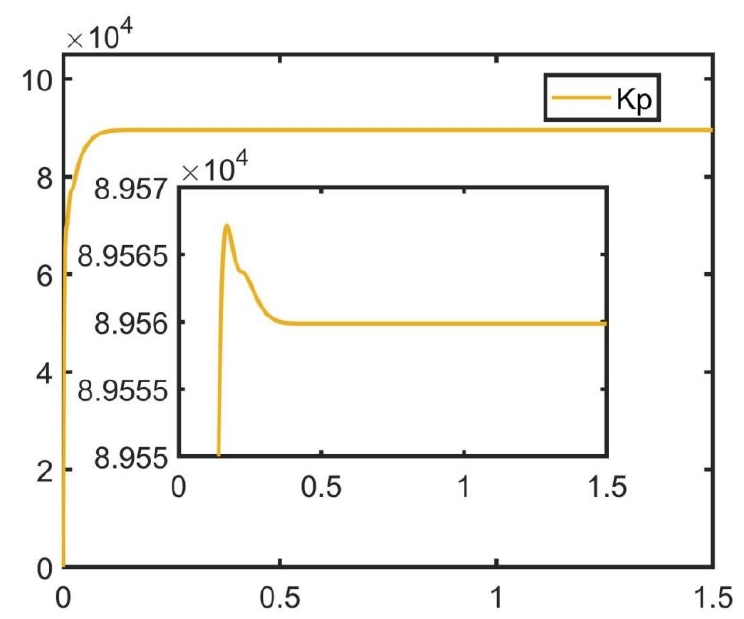
Figure 5. Adaptive adjustment curve of k p